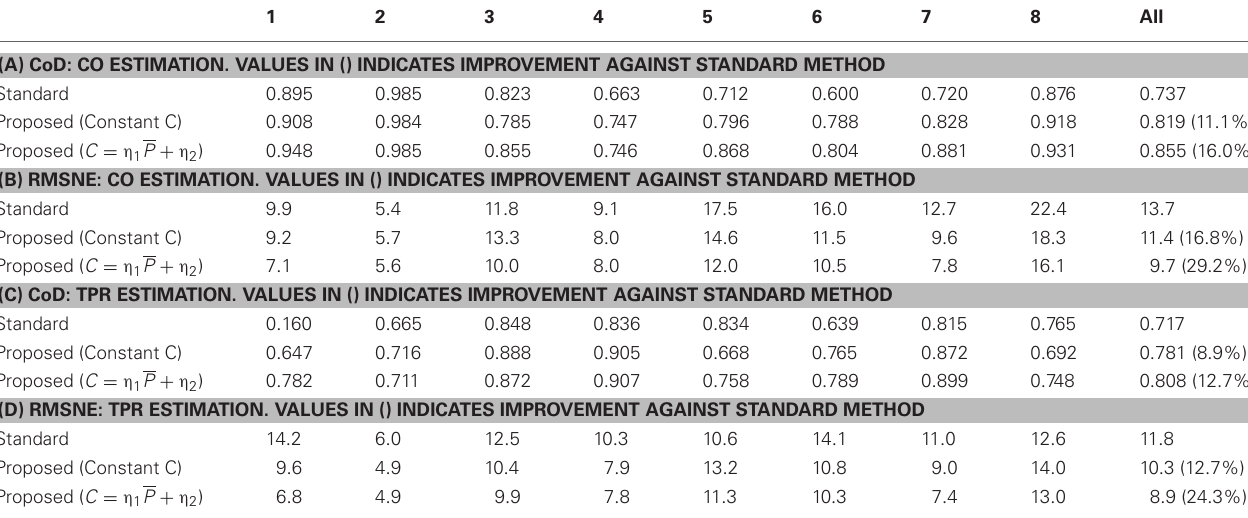
Table 2 | CoD and RMSNE associated with standard versus proposed CO and TPR estimation methods. 1 2 3 4 5 All